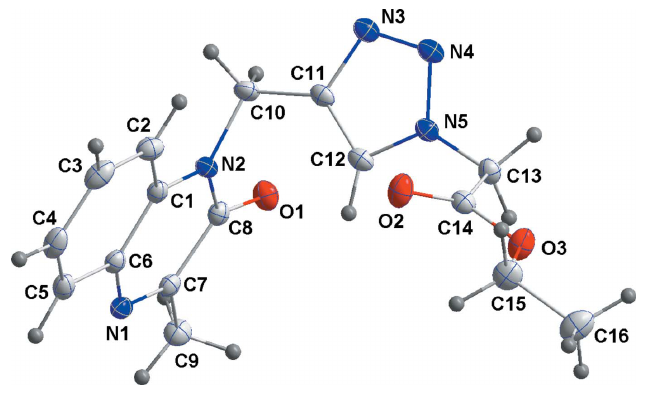
Figure 1 The title molecule with the labelling scheme and 50% probability ellipsoids.